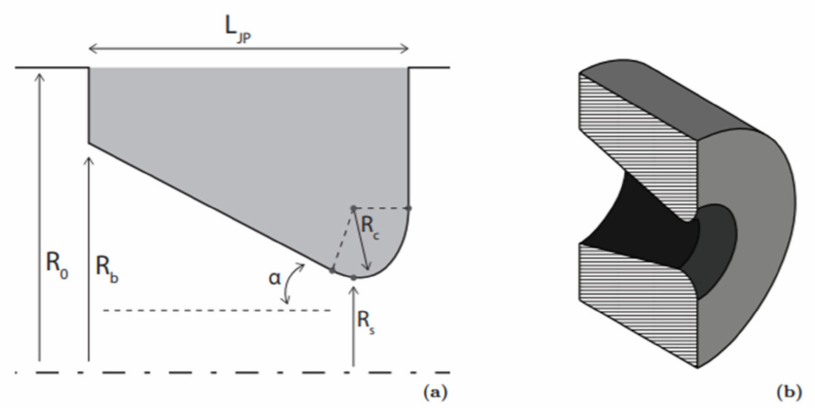
Figure 9. ( a , b ) Jet pump [91].